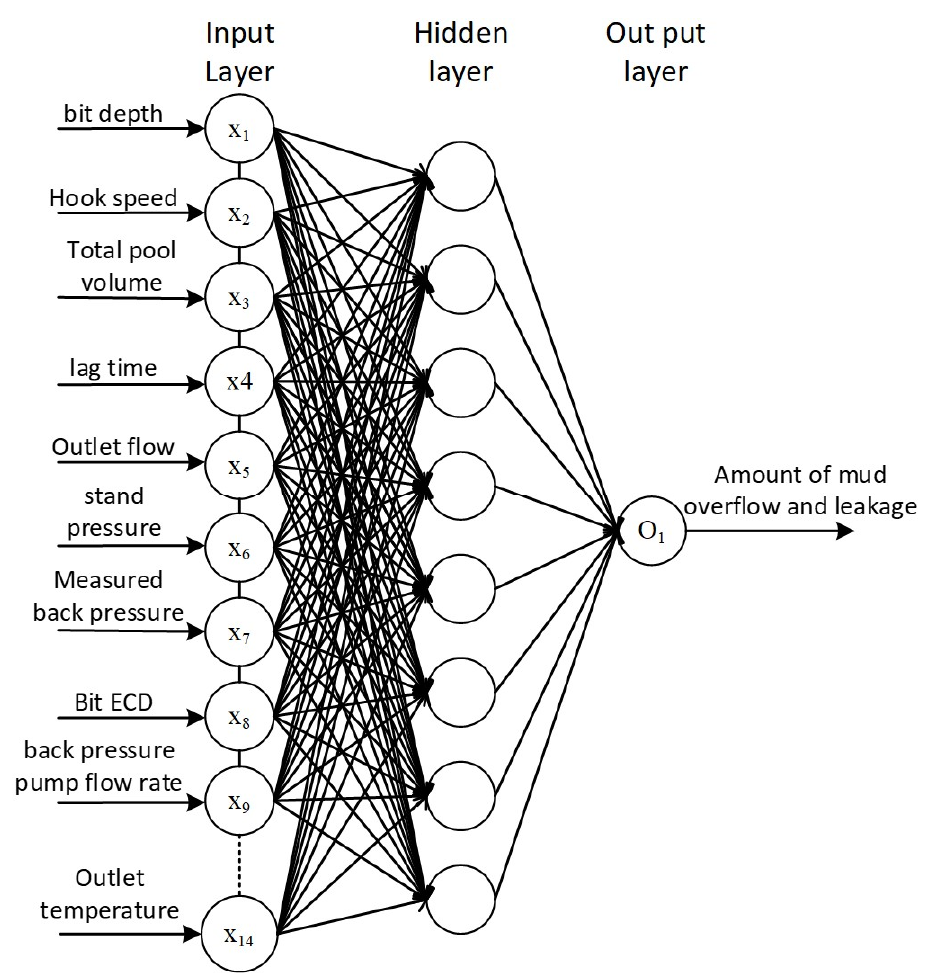
Figure 2. BP neural network topology for mud overflow and leakage prediction.